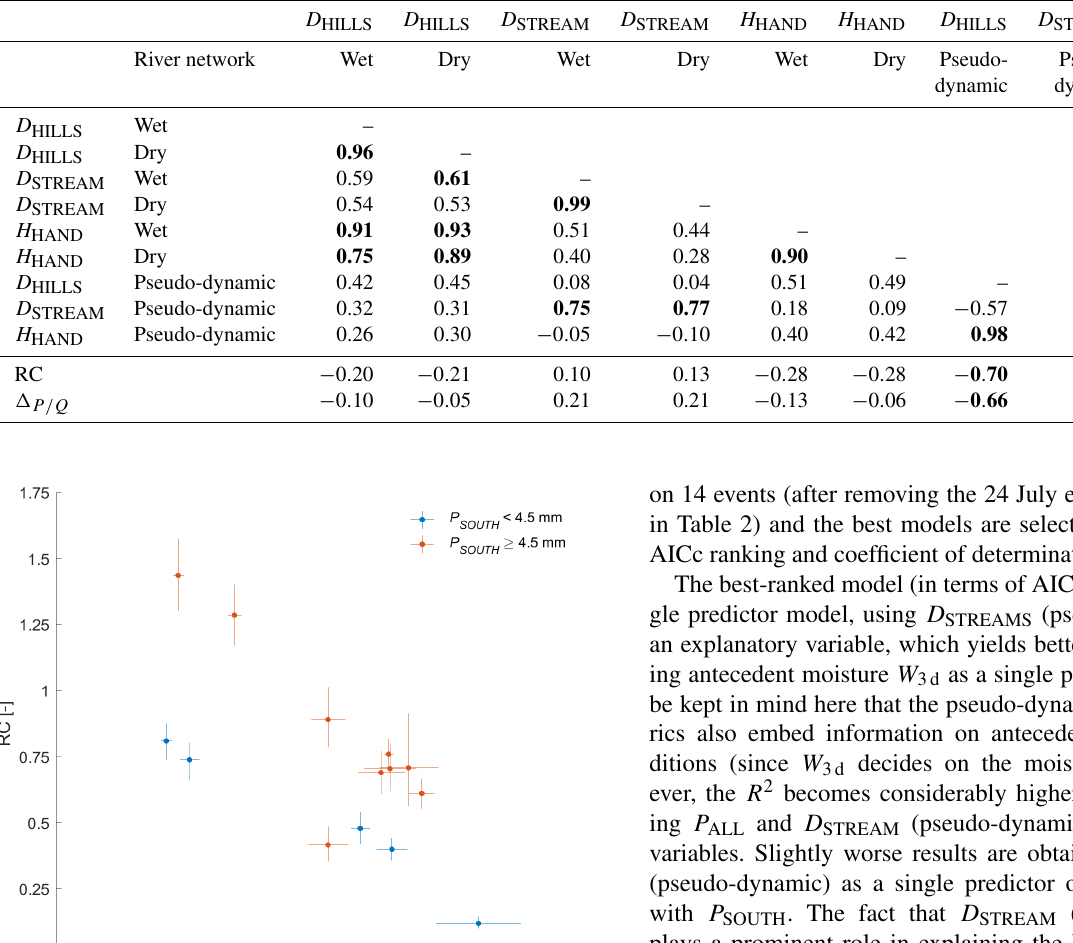
Table 5. Correlations between distance metrics for rainfall events with streamflow response (series no. 4 in Table 2). Absolute values equal to or higher than 0.60 are in bold. Correlations for all rainfall events are available in the Table S2 in the Supplement.